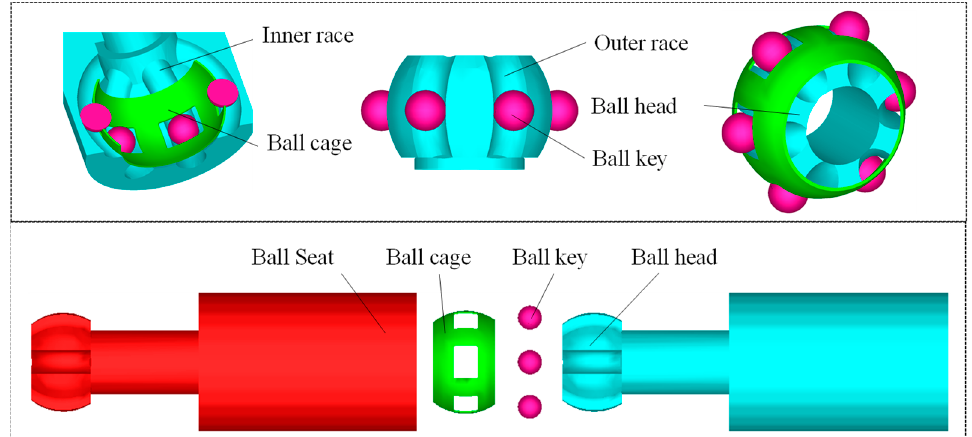
Figure 2. Structure of ball cage flexible joint.